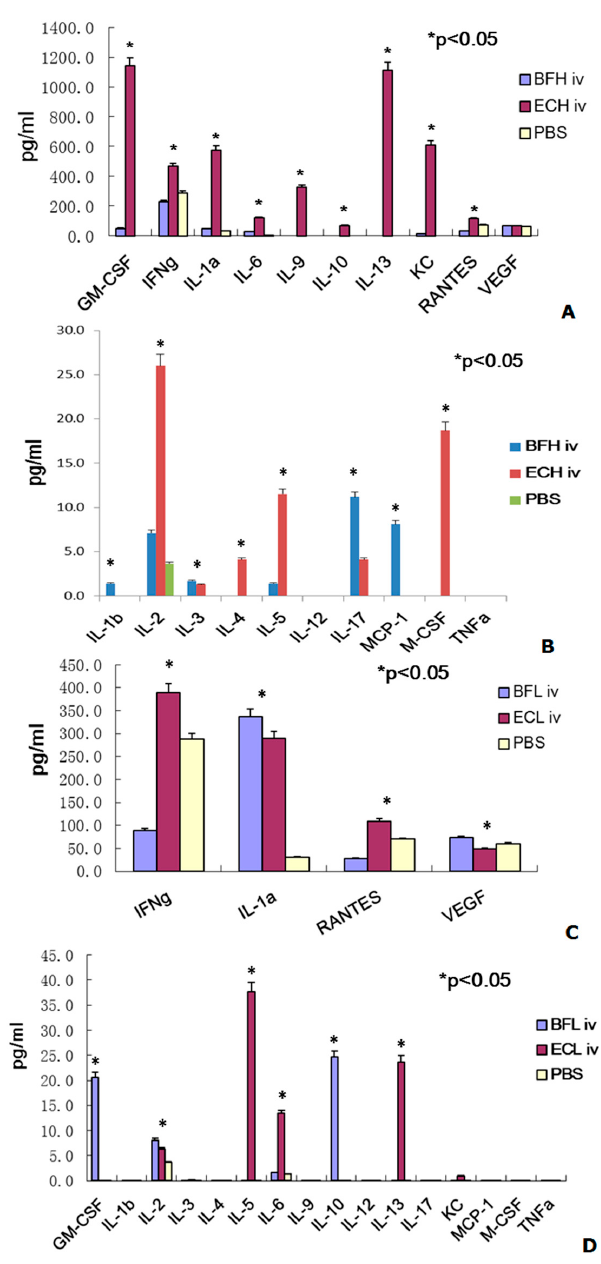
Figure 3. Comparing the cytokine profiles differentiation between BF-rTK and E. coli in BALB/c mice via intravenous (IV) ( n = 6). ( A ) Cytokine levels expressed in IV group with high dose of bacteria (1.0 × 10 6 cells/mL); ( B ) Cytokine levels expressed in IV group with high dose of bacteria (1.0 × 10 6 cells/mL); ( C ) Cytokine levels expressed in IV group with low dose of bacteria (1.0 × 10 4 cells/mL); ( D ) Cytokine levels expressed in IV group with low dose of bacteria (1.0 × 10 4 cells/mL). BFH: BF-rTK with high dose (1.0 × 10 6 cells/mL); BFL: BF-rTK with low dose (1.0 × 10 4 cells/mL); ECH: E. coli with high dose (1.0 × 10 6 cells/mL); ECL: E. coli with low dose (1.0 × 10 4 cells/mL); iv: vein injection (* p < 0.05). In contrast, five cytokines (IL-5, IL-6, IL-17, GM-CSF, and KC) in high dose of IM E. coli DH5 α and three cytokines (IL-5, IL-10, and GM-CSF) in low dose of IM E. coli were upregulated more than 10-fold, respectively, compared with the PBS control (Figure 2). Two cytokines (IFN- γ and RANTES)